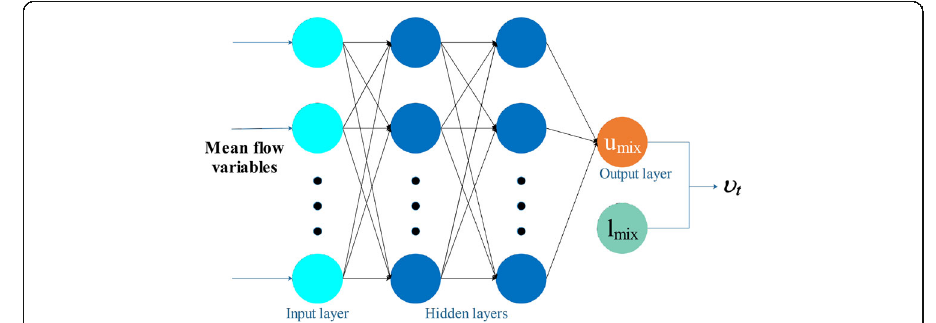
Fig. 2 Schematic of the fully-connected neural